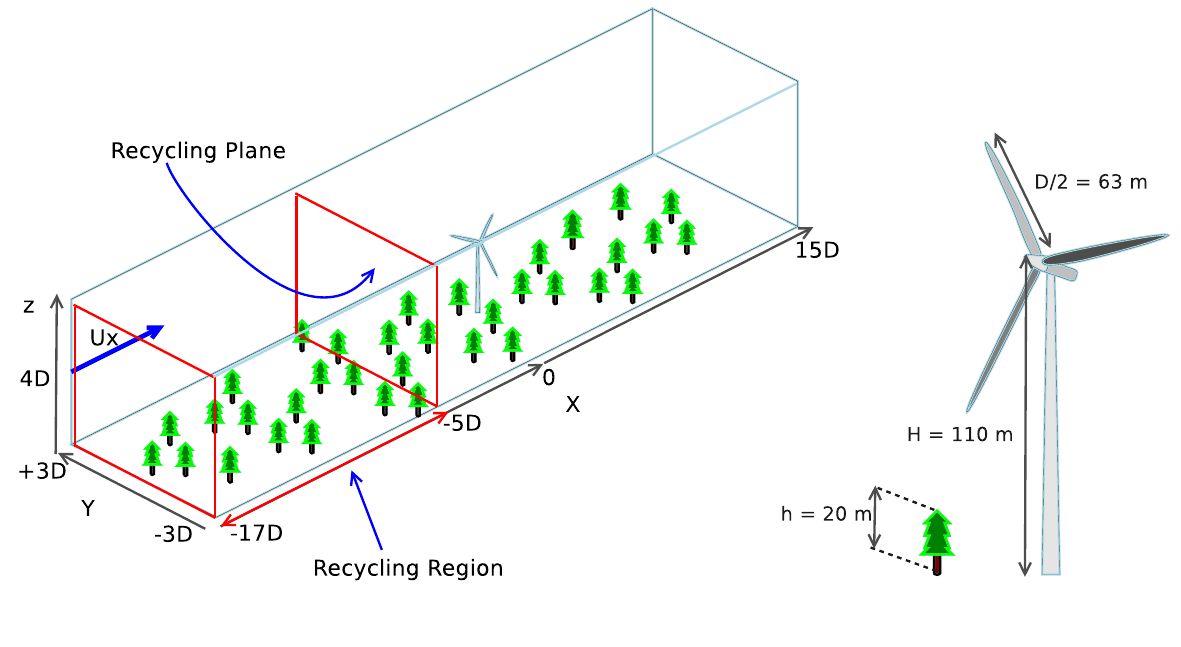
Figure 7. Computational